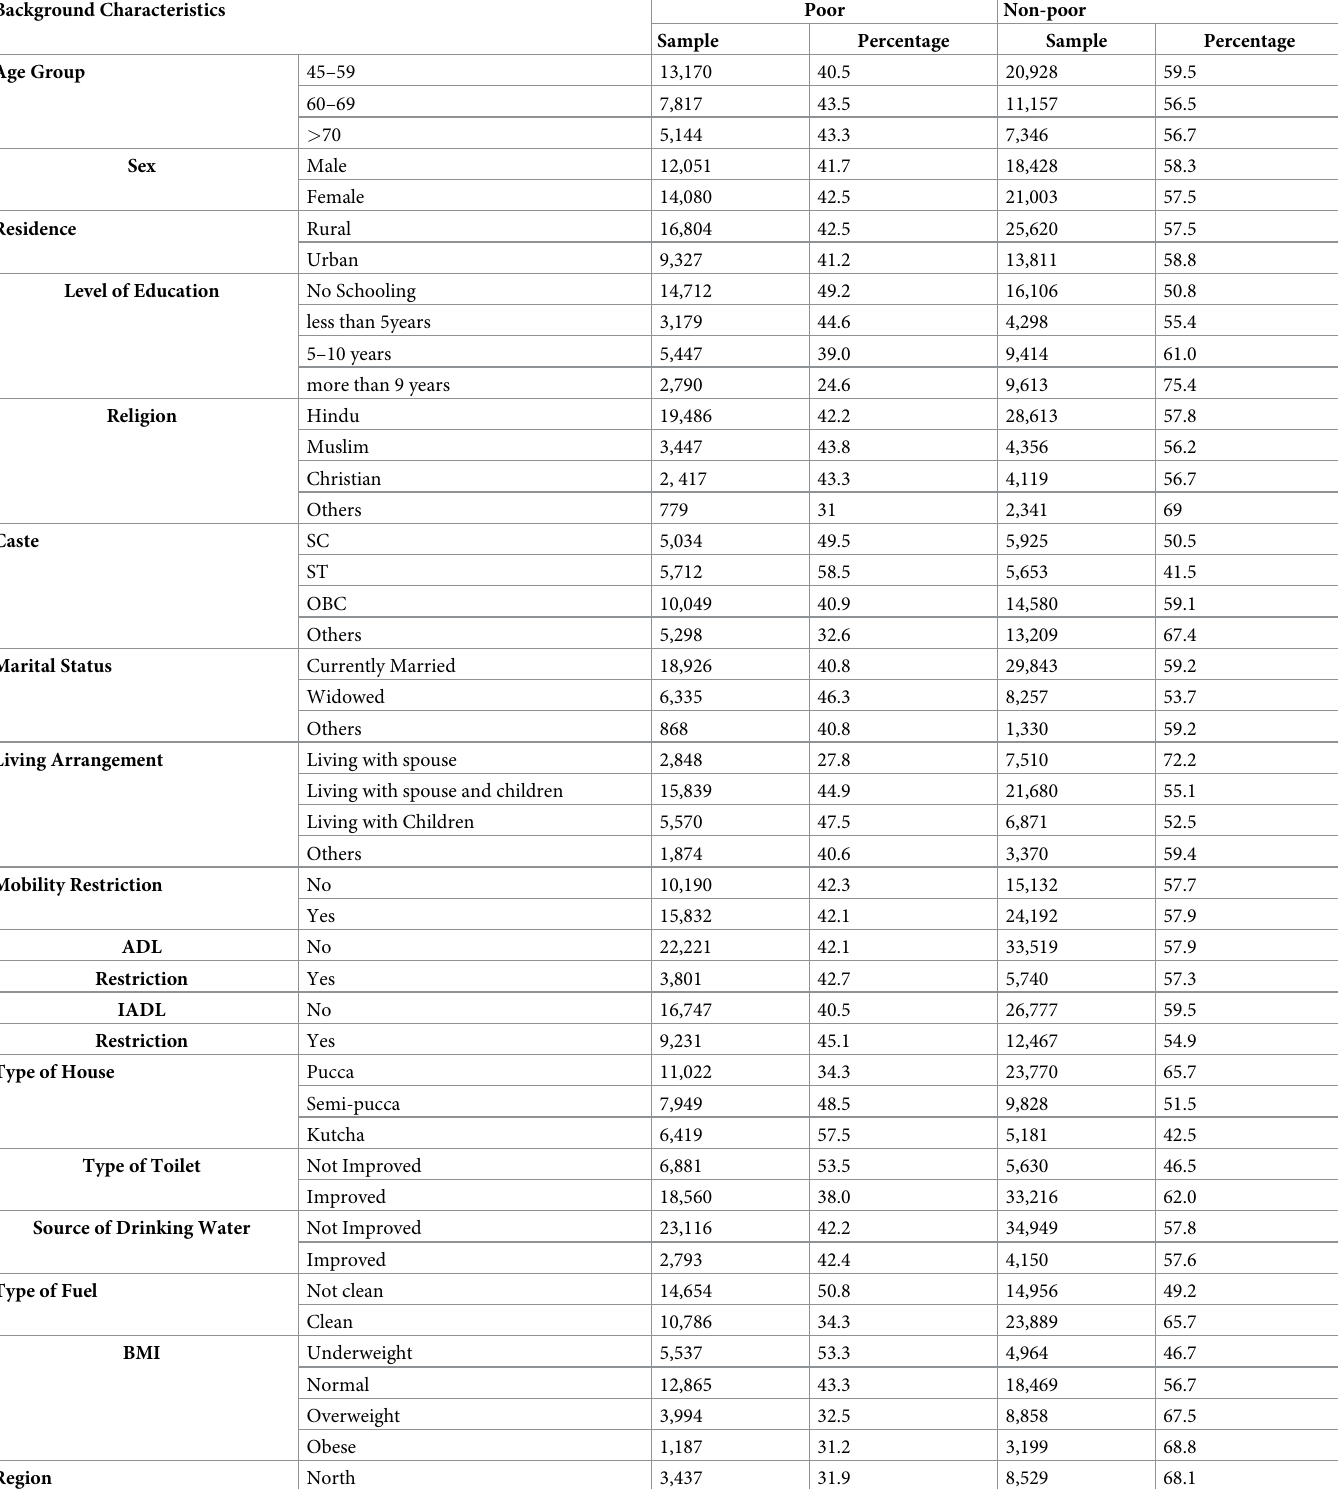
Table 1. Socio demographic profile of the study population according to their economic category. Background